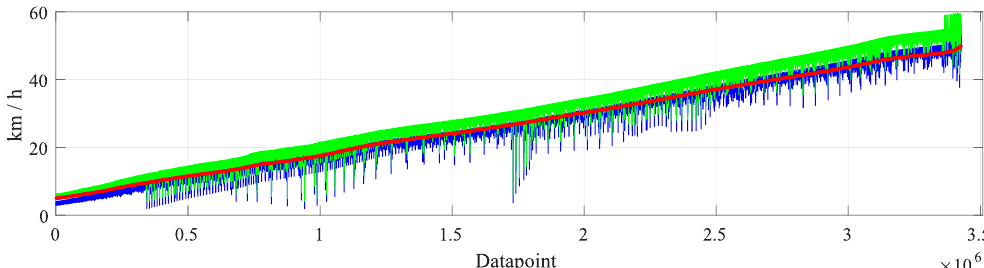
Figure 15. Comparisonbetween the reference ( v r ) , expert ( v e ) and OBD ( v o ) velocities. In order to show the relation between the OBD and the reference sensor data, the synchronized OBD data are re-arranged by ordering the reference velocity in ascending order. Then, first, with respect to Equation (24), the relation r v between each reference velocity v r and its corresponding OBD measurement v o is defined, with respect to the upper limit of the interval indicated by the equation. This is obtained as follows: